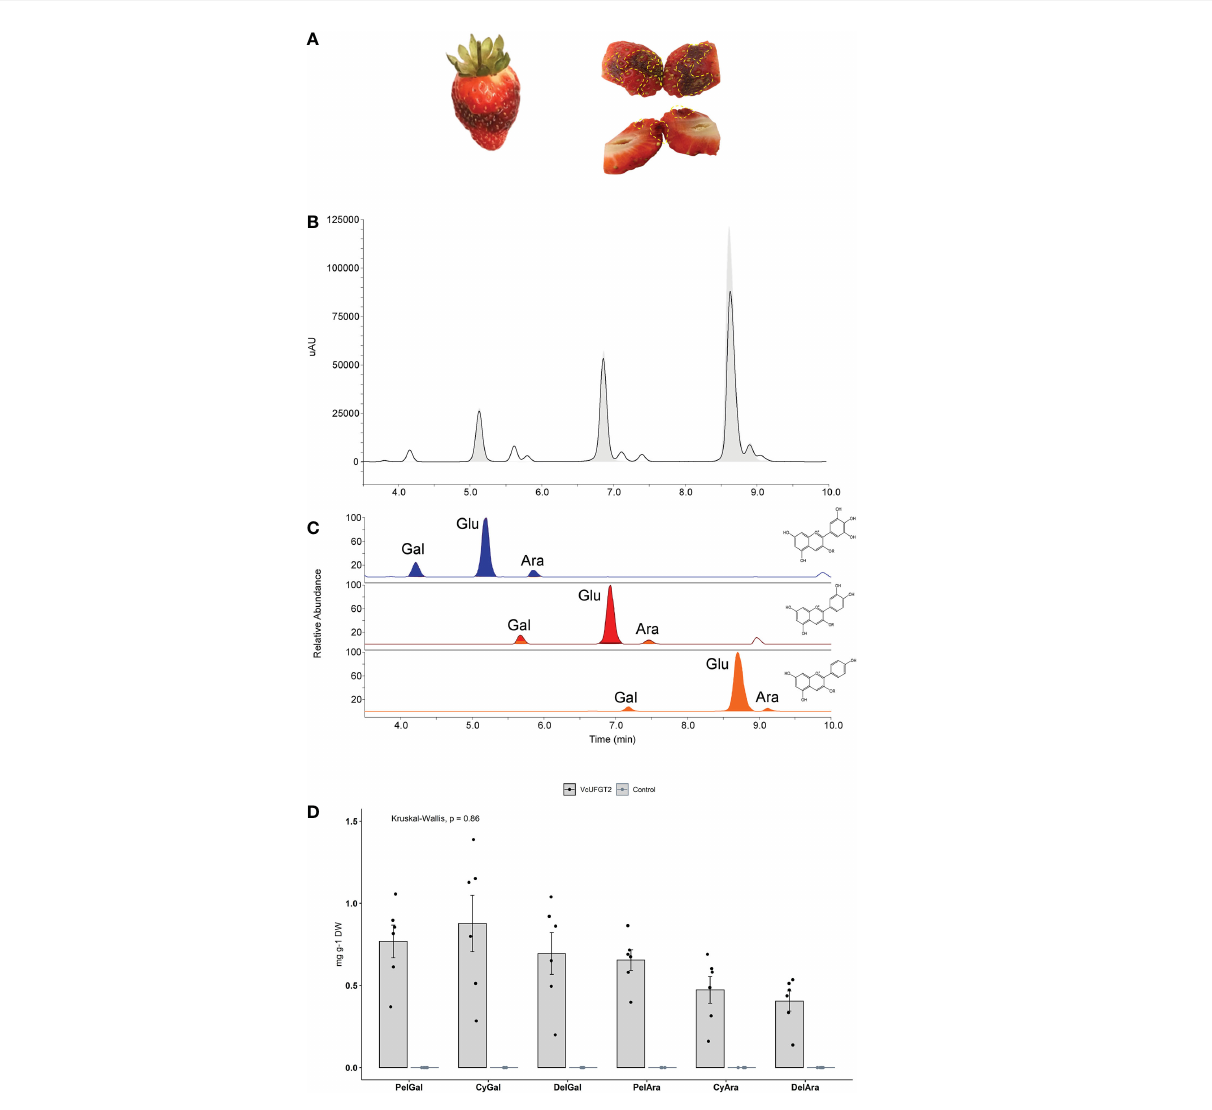
FIGURE 5 Anthocyanin pro fi le of strawberry fruit overexpressing VcUFGT2 in a VcMYBA1 and AmF3´5´H – co-expression background. (A) Representative images of whole (left) and bisected (right) strawberry fruit in fi ltrated with VcMYBA1 + AmF3´5´H . Dotted yellow lines highlight transformed tissue showing darken colour that was sampled for further analysis. (B) Chromatogram indicating retention times of compounds from control (grey fi ll) and VcUFGT2 -in fi ltrated (not fi lled) fruit at 530 nm. (C) Retention times of MS transitions for delphinidin- (blue; 465, 435), cyanidin- (red; 449, 419) and pelargonidin-derived (orange; 433, 403) anthocyanins. Gal: Galactoside; Glu: Glucoside; Ara: Arabinoside. (D) Bargraph visualising mean concentration ± standard deviation (N=6) of anthocyanidin-3- O -galactosides and -arabinosides following strawberry transient transformation 5 days after in fi ltration. While these anthocyanins were not detected in control samples, concentrations of individual anthocyanins were not signi fi cantly different in VcUFGT2 -in fi ltrated fruit. Pel, Pelargonidin; Cy, Cyanidin; Del,